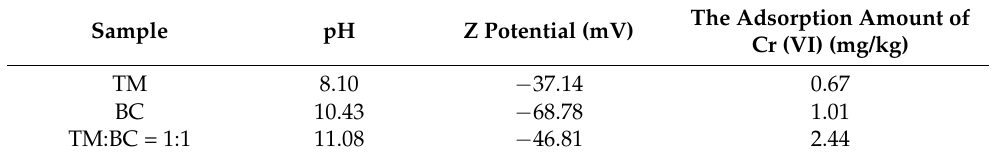
Table 3. pH, Zeta-potential values and the adsorption amount of Cr (VI) of some samples in the experiments.